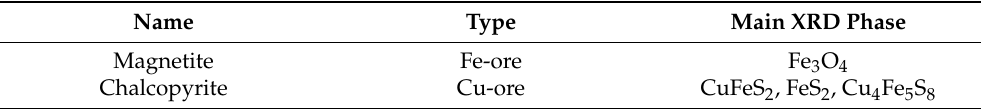
Table 1. Phase composition of the magnetite and